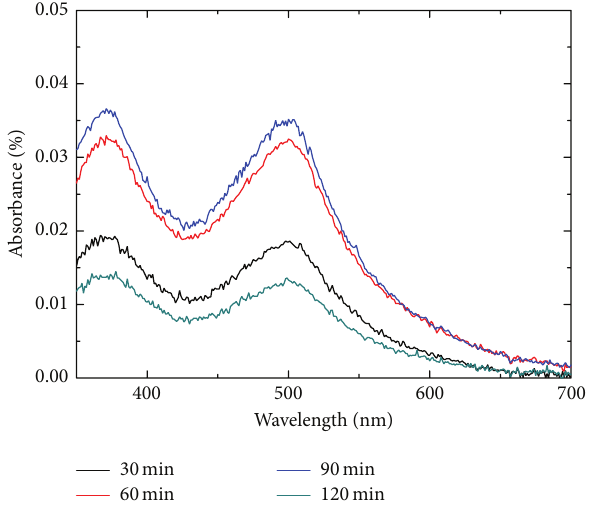
Figure 5: IPCE spectra of DSSCs with the ZnO nanowires with different growth